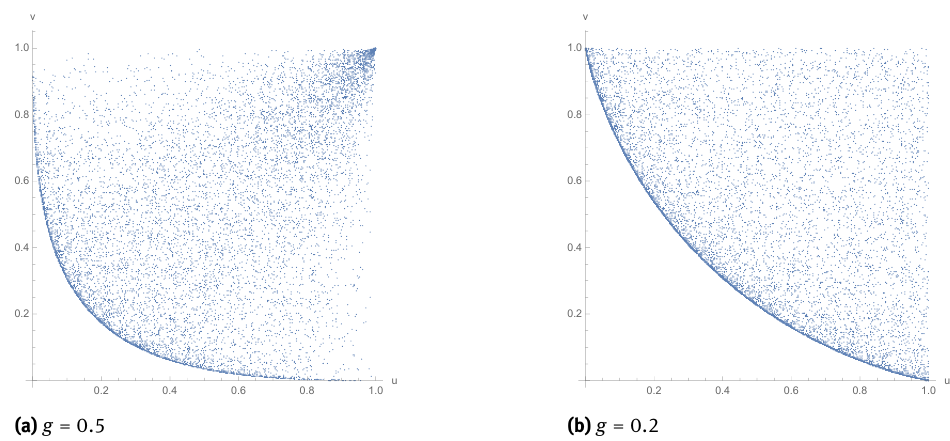
Figure 8: Two simulations from a shifted exponential Lorenz copula for different g .